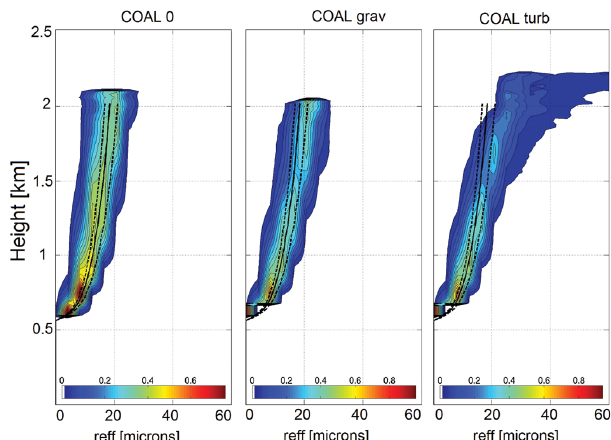
Fig. 8. CFAD of the effective radius ( r eff ). Solid and dashed lines represent the adiabatic model profiles for the CCN concentration of 120mg − 1 and 90/150mg − 1